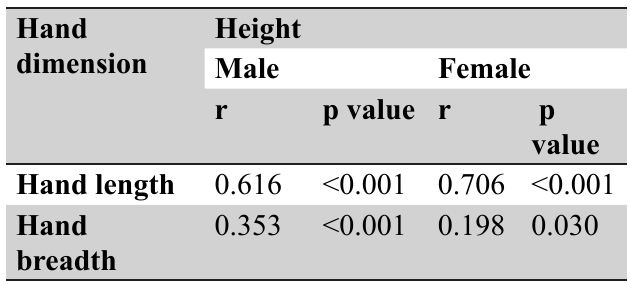
Table 2: Correlation coefficient of height with hand length and hand breadth